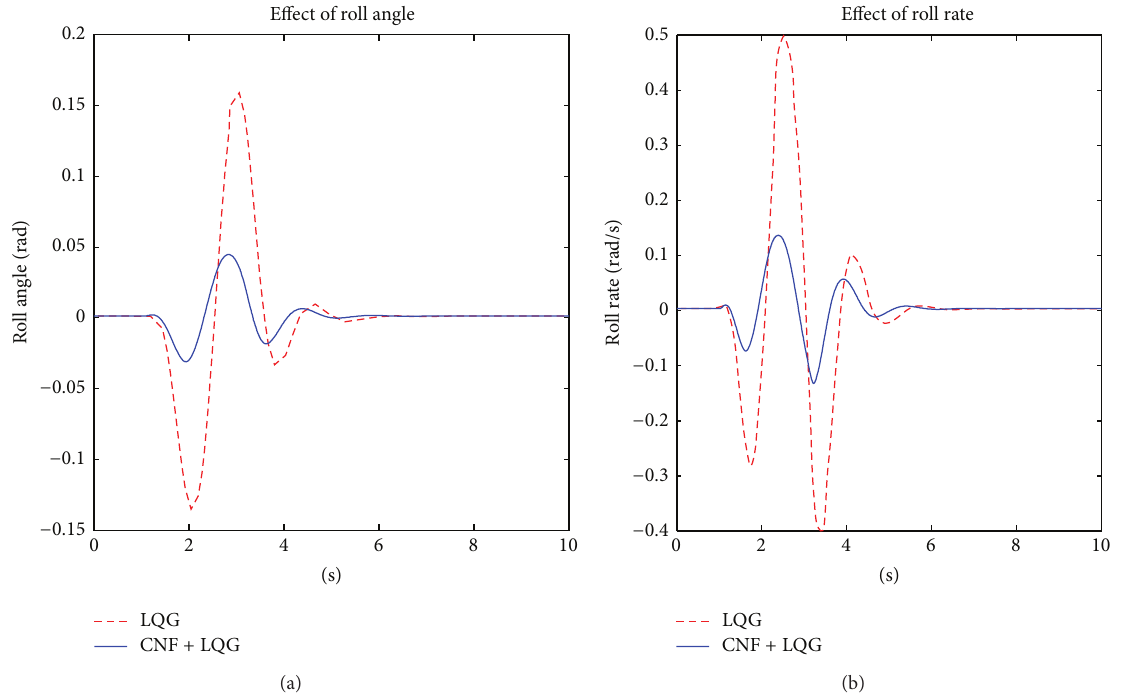
Figure 8: Single sine input test (a) roll angle response and (b) roll rate response.